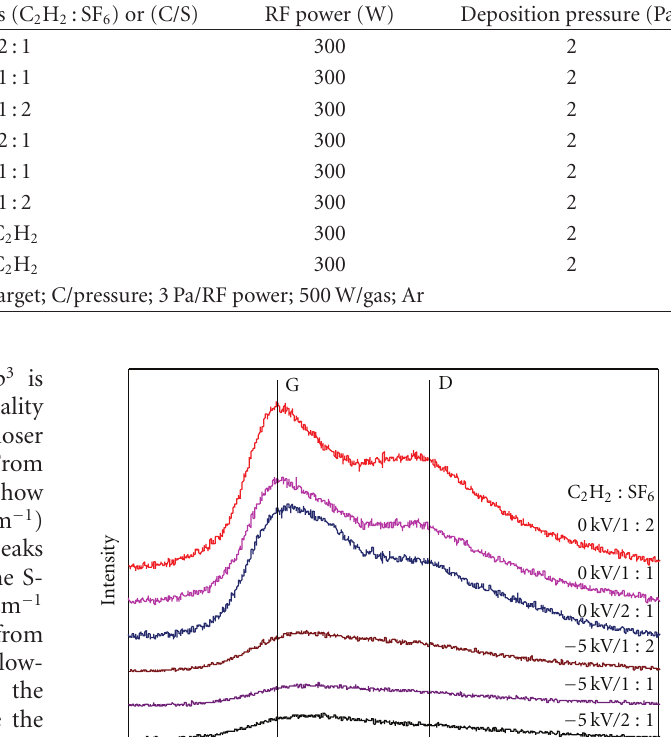
Table 1: Deposition conditions for S-DLC films, CH-DLC films, and DLC-SP film. Sample no.